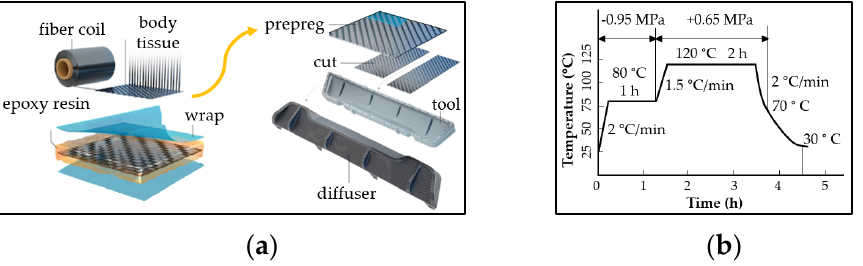
Figure 1. Production of the CFRP composite; ( a ) preparation flow chart; ( b ) curing cycle in the au ‐ toclave.